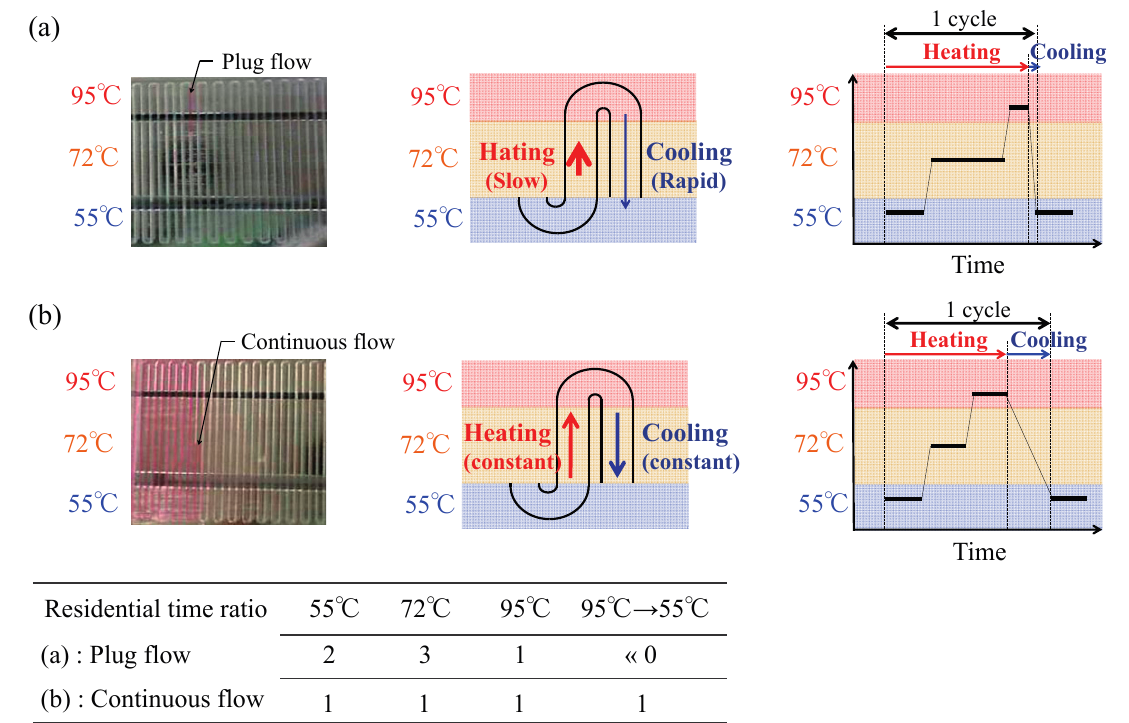
Figure 3. Features of the thermal cycle based on the liquid plug-flow and continuous flow in serpentine rectangular flow microchannel: ( a ) Plug flow-based thermal cycling technique presented by using a temperature gradient between 95 ° C and 55 ° C; ( b ) Continuous flow-based thermal